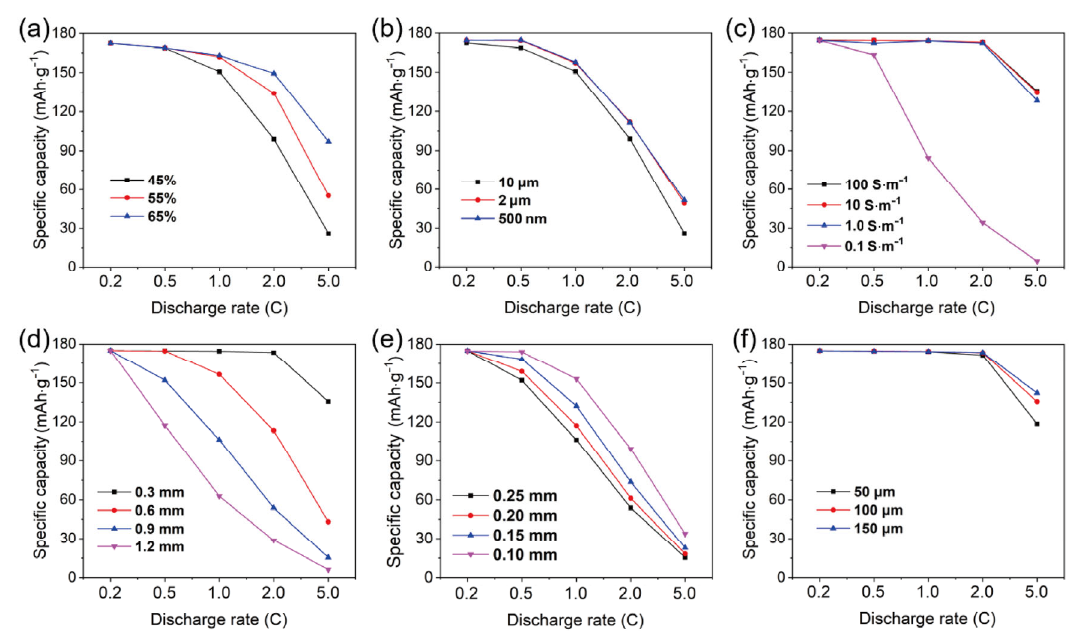
Fig. 3 Effects of various electrode parameters on the electrochemical performance: (a) specific capacity variation with discharge rate for 0.3 mm thick 3D grid porous electrodes with different porosities ( d : 10 μ m), (b) specific capacity variation with discharge rate for 0.3 mm thick 3D grid porous electrodes with different active material particle diameters ( ε : 45%), (c) specific capacity variation with discharge rate for 0.3 mm thick 3D grid porous electrodes with different electronic conductivities ( ε : 65%, d : 2 μ m), (d) specific capacity variation with discharge rate for 3D grid porous electrodes with different thicknesses ( ε : 65%, d : 2 μ m), (e) specific capacity variation with discharge rate for 0.9 mm thick 3D grid porous electrodes with different line widths ( ε : 65%, d : 2 μ m), and (f) specific capacity variation with discharge rate for 0.3 mm thick 3D grid porous electrodes with different pore sizes ( ε : 65%, d : 2 μ